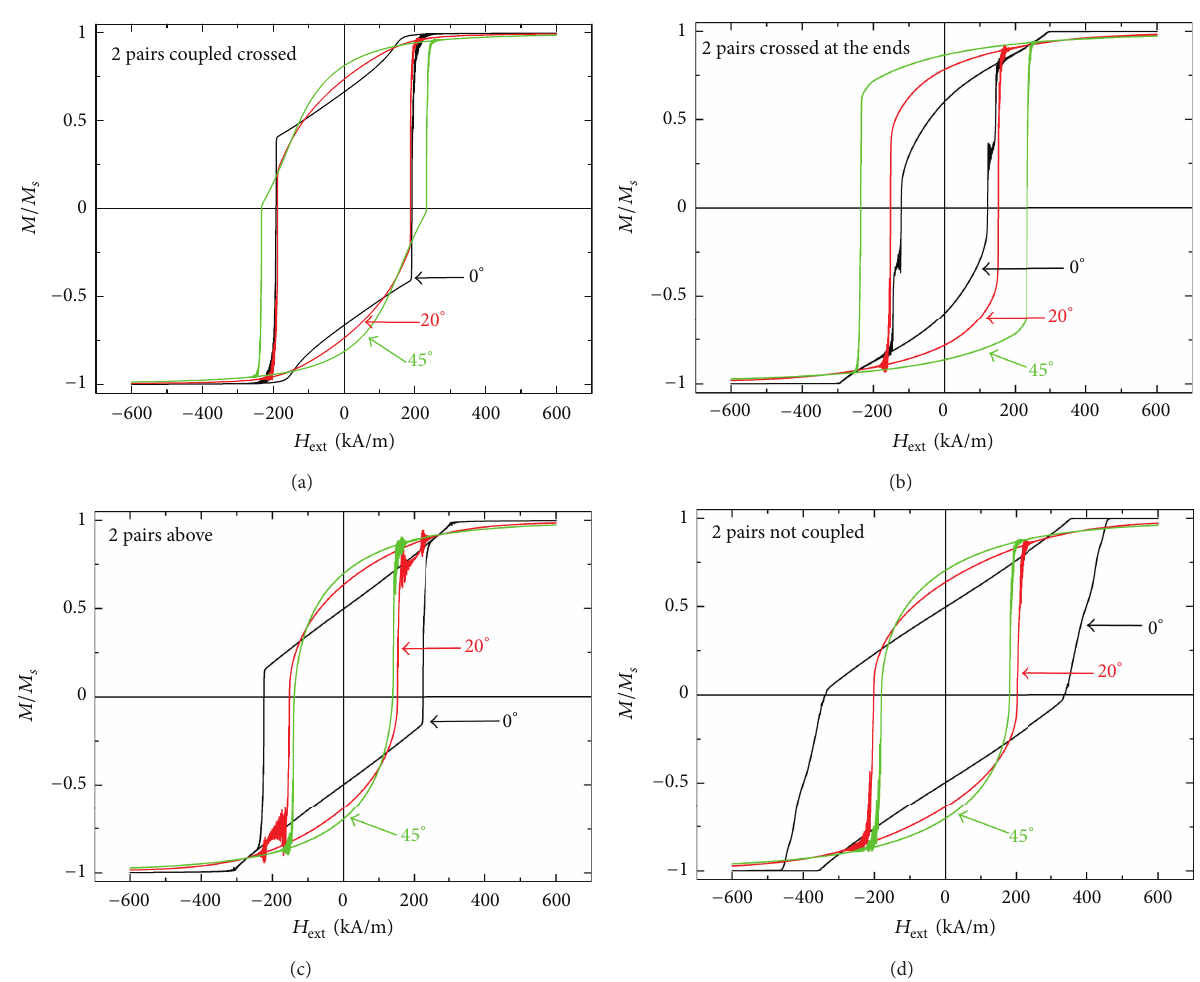
Figure3:SimulatedhysteresiscurvesforthesamplesdepictedinFigure 1,exemplarilyshownfororientationsrelativetotheexternalmagnetic field of 0 ∘ (i.e., parallel to one pair of wires), 20 ∘ , and 45 ∘